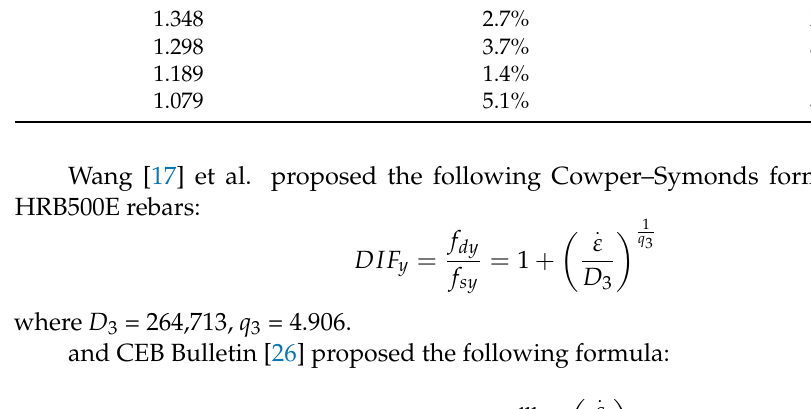
Table 8. Deviation analysis table of DIFu fitting value and experimental value. Average Deviation between Maximum Deviation Strain Rate//s DIFu Fitting Value and between DIFu Fitting Value Experimental Value and Experimental